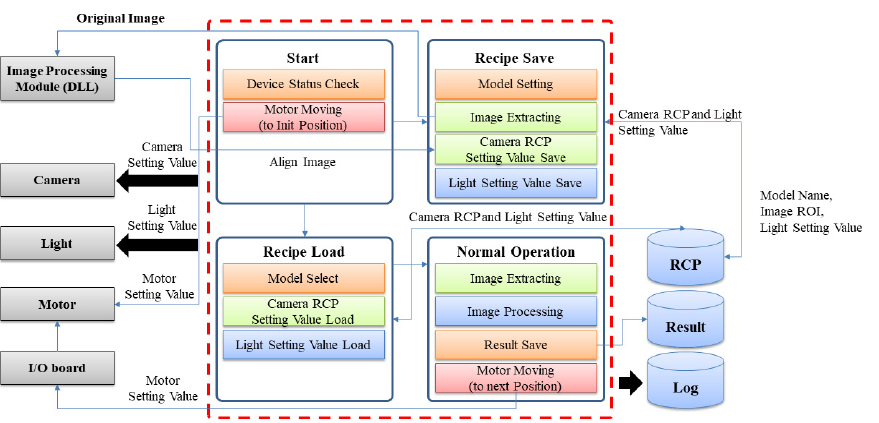
Figure 3. Program structure.